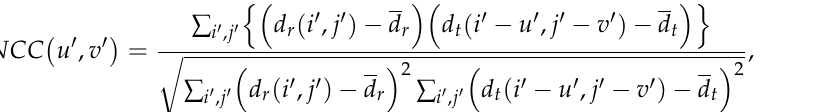
Figure 1. Digital image correlation method processing concept.